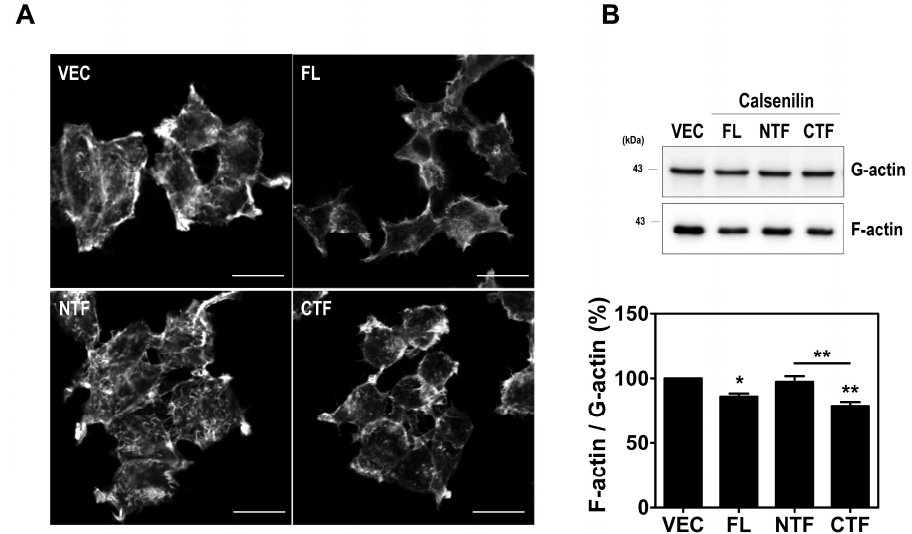
Figure 6. Overexpression of calsenilin-FL and -CTF decreased F-actin formation. ( A ) Immunocytochemical staining for F-actin in HEK293 cells expressing VEC, calsenilin-FL, -NTF, or -CTF. The cells were fixed with 4% PFA and permeabilized with 0.2% Triton X-100 in phosphate-buffered saline (PBS). F-actin (green) was stained with Alexa Fluor 555-phalloidin. All pictures are representative of multiple images from three independent experiments. Scale bars, 20 μm. ( B ) The expression of F-actin/G-actin as assessed by F-actin/G-actin in vivo assay in HEK293 cells expressing VEC, calsenilin-FL, -NTF, or -CTF. The intensities of the bands in each panel were measured and quantified for each group, and the values are expressed as the mean ± SEM of three independent experiments. Statistical differences were determined by one-way ANOVA test with Tukey’s post hoc test ( n = 3, * p < 0.05; ** p < 0.01).